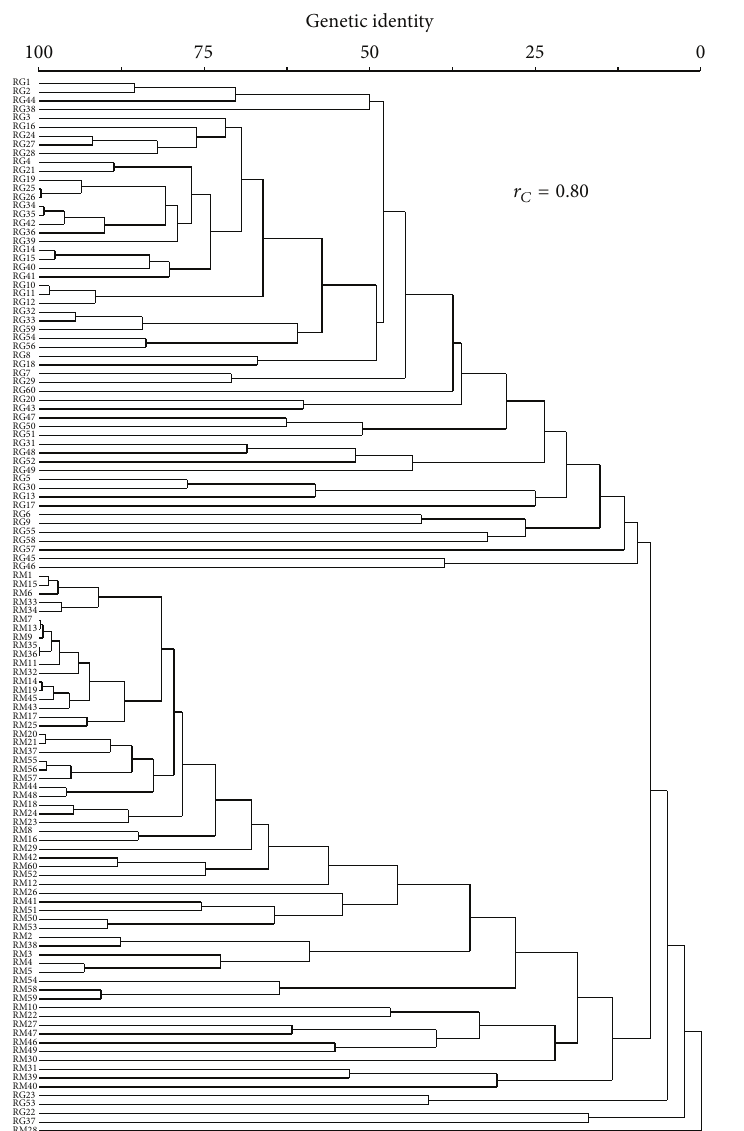
Figure 3: Hierarchical cluster analysis of Calophyllum brasiliense genotypes in populations from Rio Grande (RG) and Rio das Mortes (RM) using UPGMA, based on data obtained with RAPD. RC: cophenetic correlation.